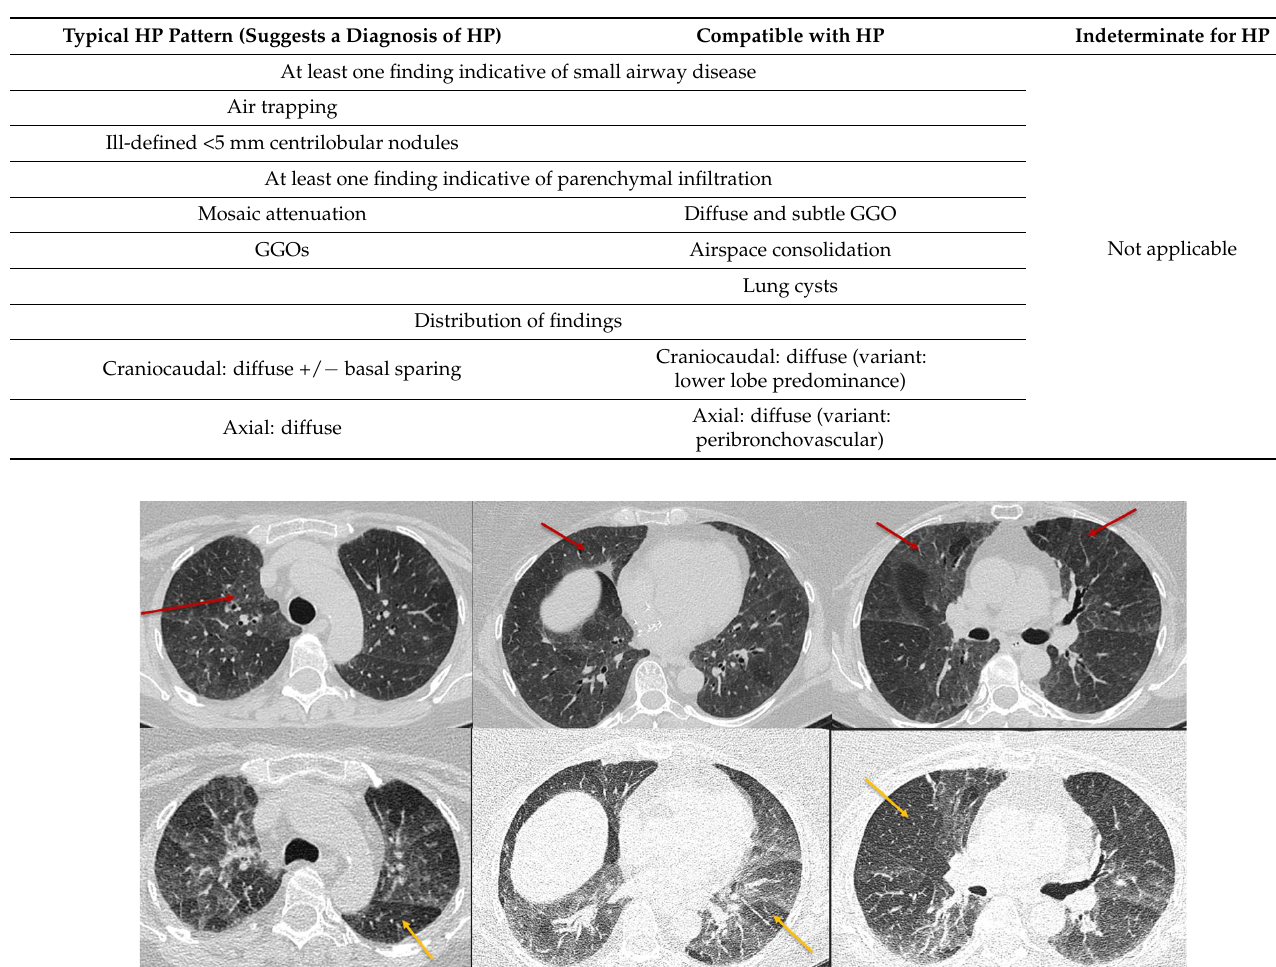
Table 3. Patterns of non-fibrotic HP on chest HRCT scan.